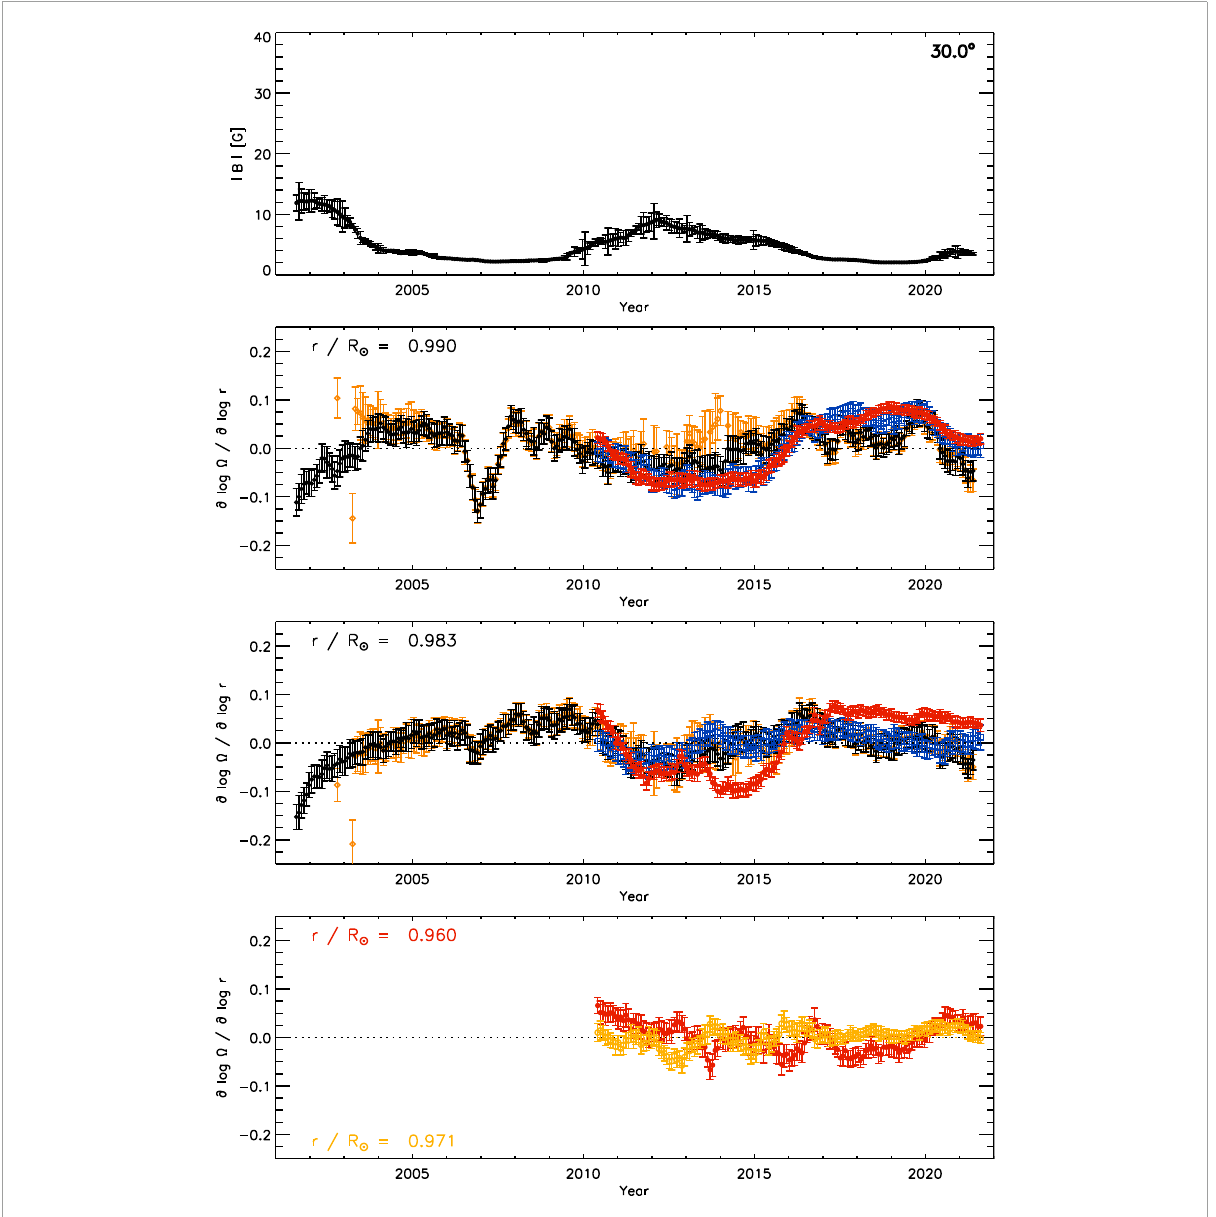
FIGURE 12 The temporal variation of MAI (top) and that of the residual radial gradient of the solar rotation rate after subtracting the temporal mean at every latitude at three depths (2nd: .990 R ⊙ , 3rd: .983 R ⊙ , bottom: .960 R ⊙ ) at 30° latitude averaged over both hemispheres derived from 15°-tile RDA (black diamonds: GONG, blue squares: HMI) and 30°-tile RDA (red circles: HMI) smoothed with a rectangular boxcar over 13 CRs. For the GONG quiet-region subset (orange open diamonds), the mean of the complete data set was subtracted. The bottom panel includes the variation at .971 R ⊙ (orange open circles). Compare with Figures 9 , 11